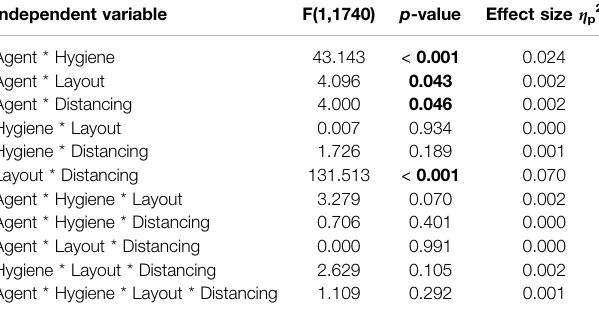
TABLE 2 | ANOVA results (interaction effects). Signi fi cant p -values are